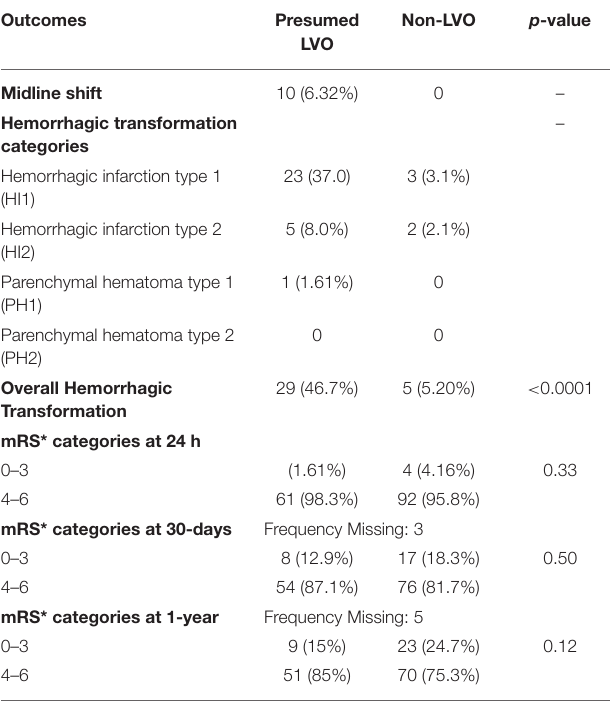
TABLE 3 | A comparison of outcomes among participants with and without presumed